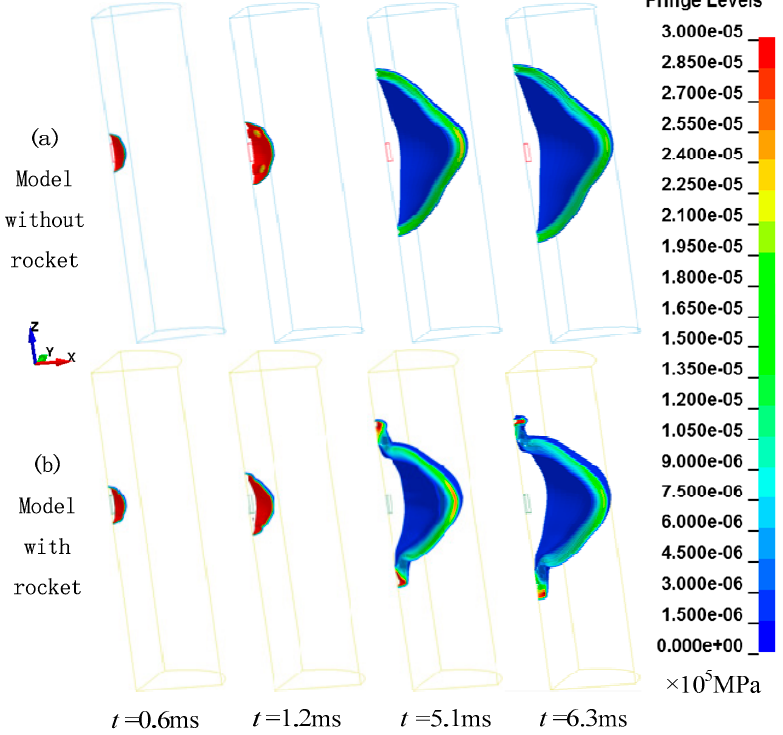
Figure 7. Pressure contours of air blast at different time after stage-3 explosion.